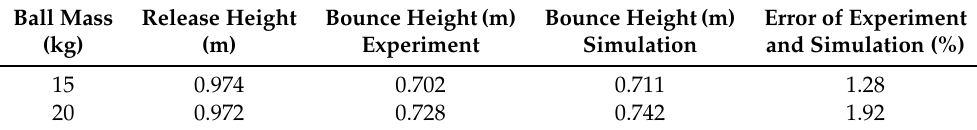
Table 5. Comparison of experiment and simulation results of single bounce. Ball